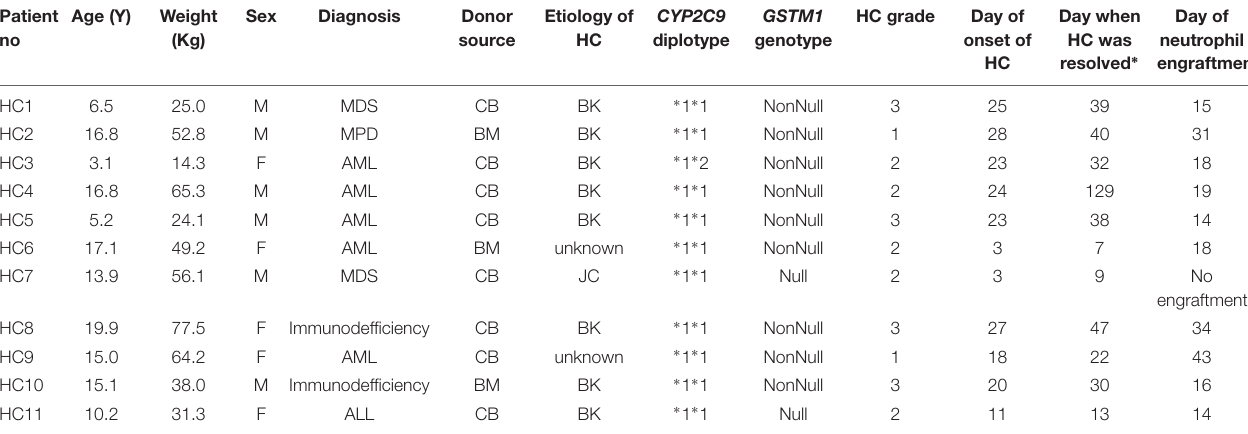
TABLE 4 | Clinical characteristics of patients with hemorrhagic cystitis. Patient no